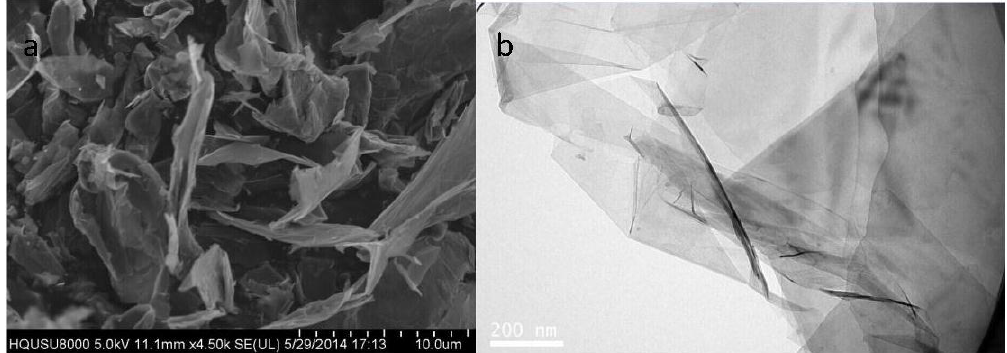
Figure 1. The raw graphene nano-platelets (GNPs) morphology: ( a ) scanning electron microscope (SEM) image; ( b ) transmission electron microscope (TEM) image.